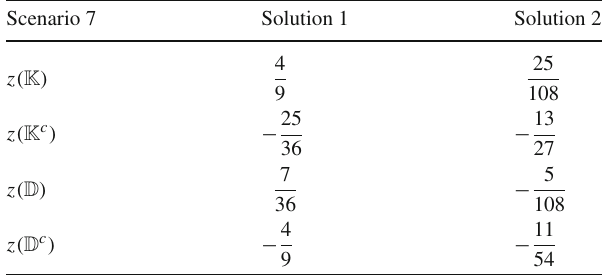
Table 30 The same as in Table 29, but for the hypercharges of Case 2 of Table